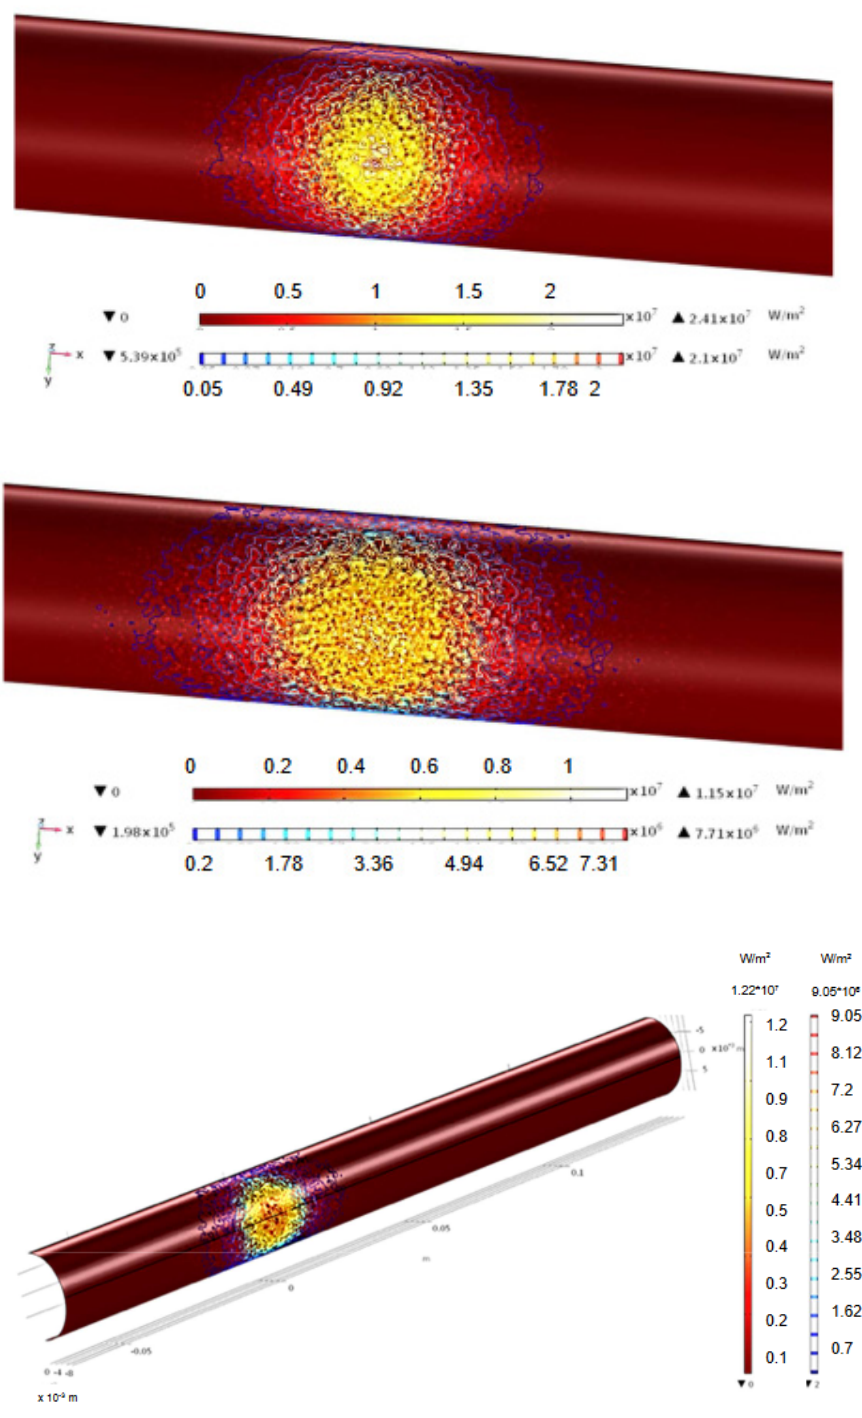
Figure 13. Three-dimensional distribution of thermal power deposited in the central section of receiver. Ideal case ( above ) or real case: perfectly smooth and reflective parabolic reflector; the phenomenon of solar limb darkening was neglected. Real case ( below ): parabolic reflector in which factors such as surface roughness, absorption and solar limb darkening were included.